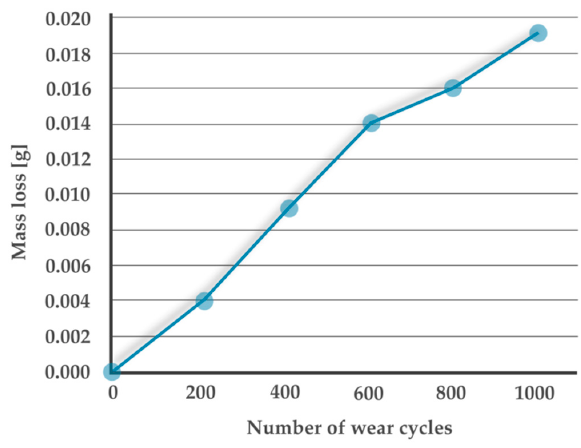
Figure 9. Wear process presented on the example of a MWCNTs 0.25 wt.% sample.